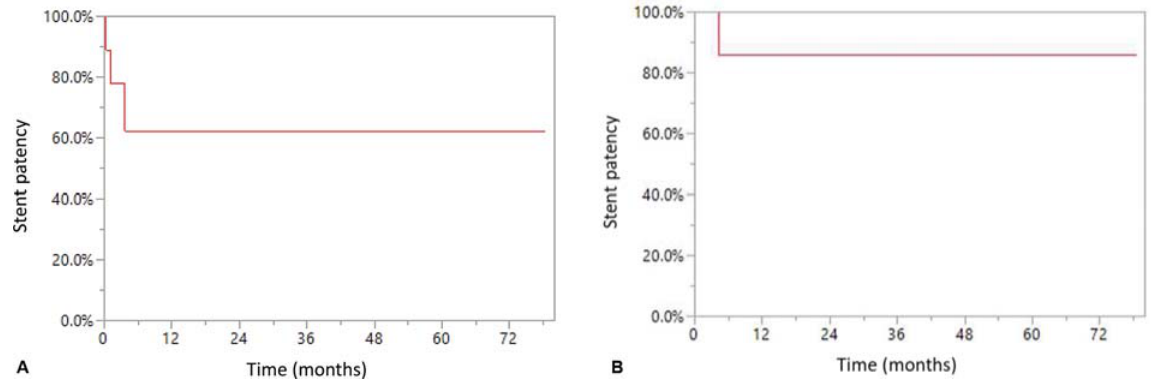
Fig. 2 Stent patency. ( A ) Primary patency. ( B ) Secondary